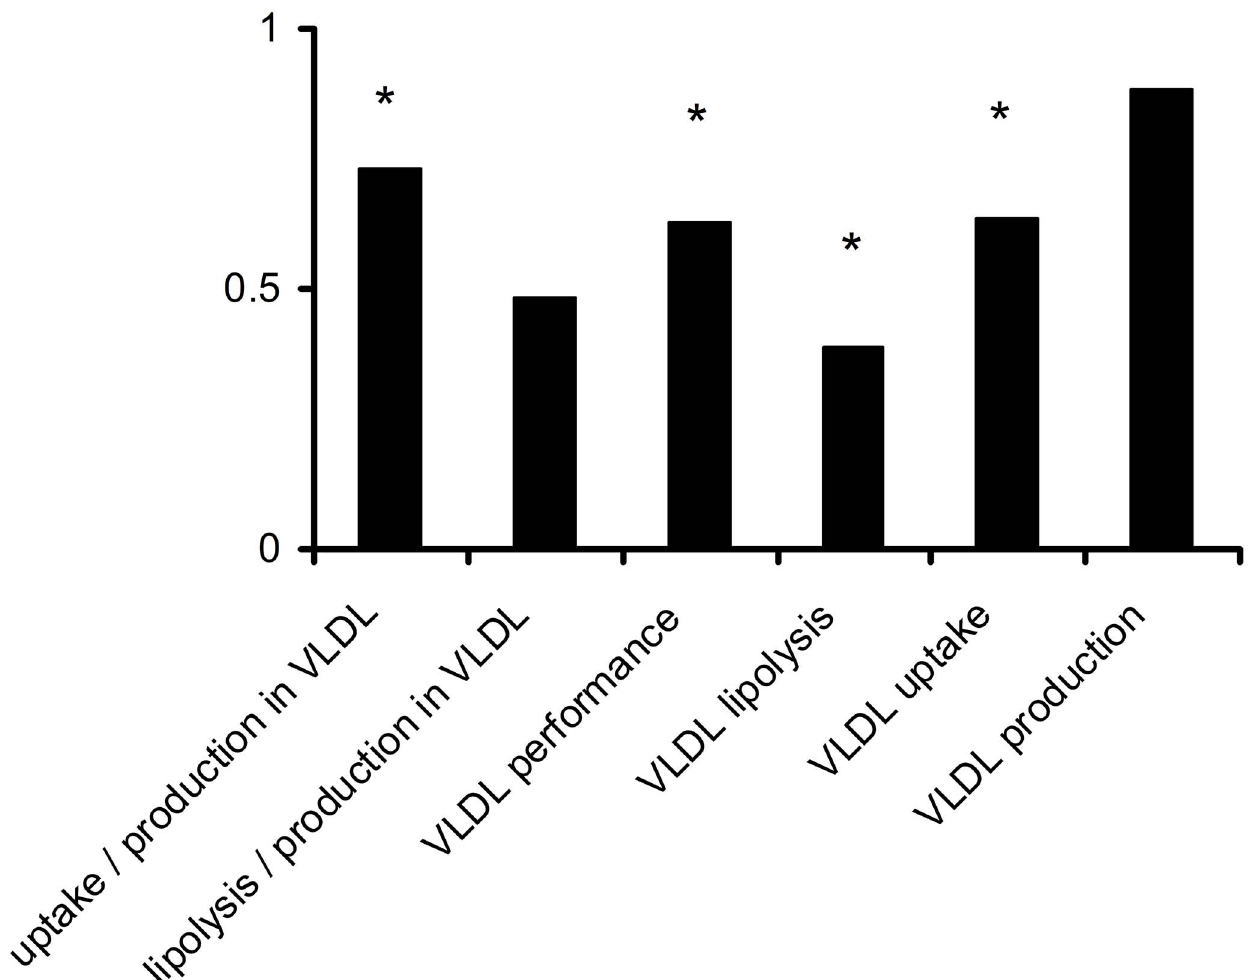
Figure 4. Ratios between average VLDL metabolism parameters after dietary MCFA supplementation versus linoleic acid supplementation; values , 1 indicate a higher value after linoleic acid supplementation. Ratios are shown to allow comparing differences after dietary supplementation between parameters with different dimensions. * Indicates a significant difference in two-way ANOVA between MCFA and linoleic acid supplementation, with p , 0.05. The first three parameters have dimensions volume/ # particles , the uptake and lipolysis measure have the dimension 1/time , and the production measure has dimension # particles/(volume * time) . Differences in VLDL triglyceride and cholesterol pool size can be found in table 2. The p-values of the significant measures are: uptake/production in VLDL (p=0.030); VLDL performance (p=0.040); VLDL lipolysis (p=0,0213); VLDL uptake (p=0.0135).